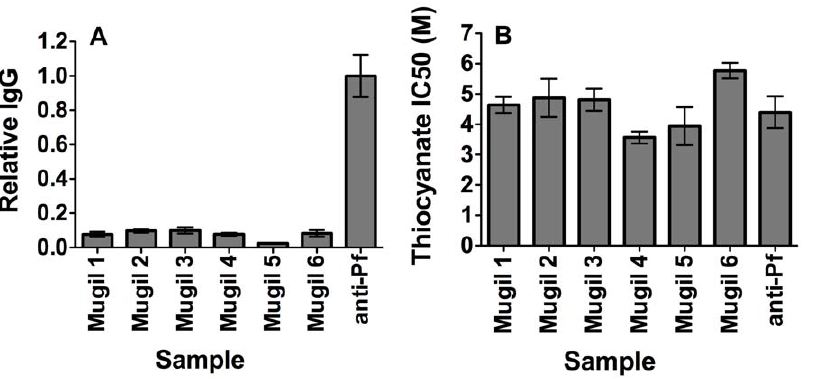
Figure 5. PfMSP1-19 antibody concentration and avidity of binding in Mugil plasma and rabbit sera. ( A ) Comparison of PfMSP1-19 specific antibody levels estimated by ELISA between Mugil plasma and growth inhibitory vaccinated rabbit sera raised against PfMSP1-19 (anti-Pf). Relative levels are expressed as a proportion of the PfMSP1-19 rabbit antisera. ( B ) Comparison of IC50 (M) for ammonium thiocyanate inhibition of PfMSP1-19 antibody binding to recombinant PfMSP1-19 for Mugil plasma and growth inhibitory vaccinated rabbit sera raised against PfMSP1-19. The 6 Mugil plasma samples tested were selected based on having high levels of PfMSP1-19 IgG as measured by ELISA. Bars represent the mean and range of 2 independent experiments (antibody concentration in Figure A) or the mean and standard deviation of three independent experiments (thiocyanate concentration in Figure B). doi:10.1371/journal.pone.0027705.g005 PLoS ONE |